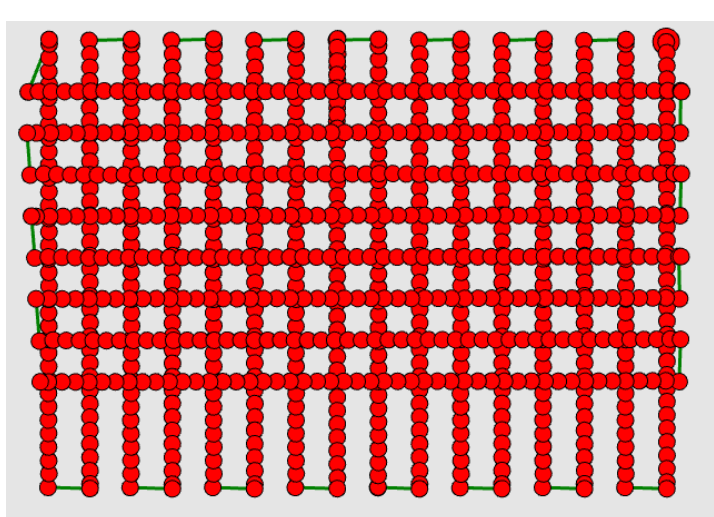
Figure 2. Unmanned aerial vehicle (UAV) orthogonal flight plan.